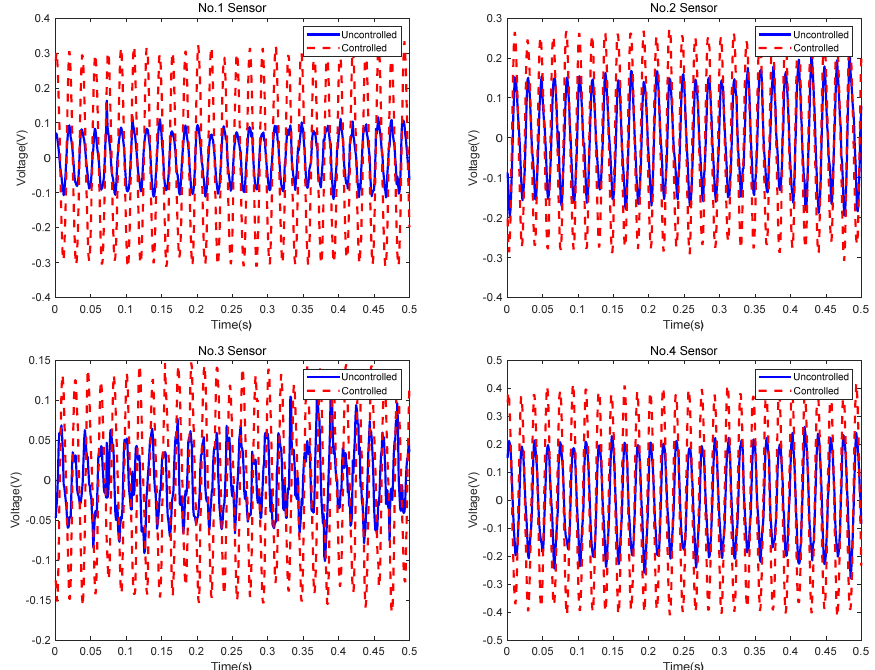
Figure 23. Sensor signals obtained by experiments (1 mV represents 0.1 m/s 2 ).